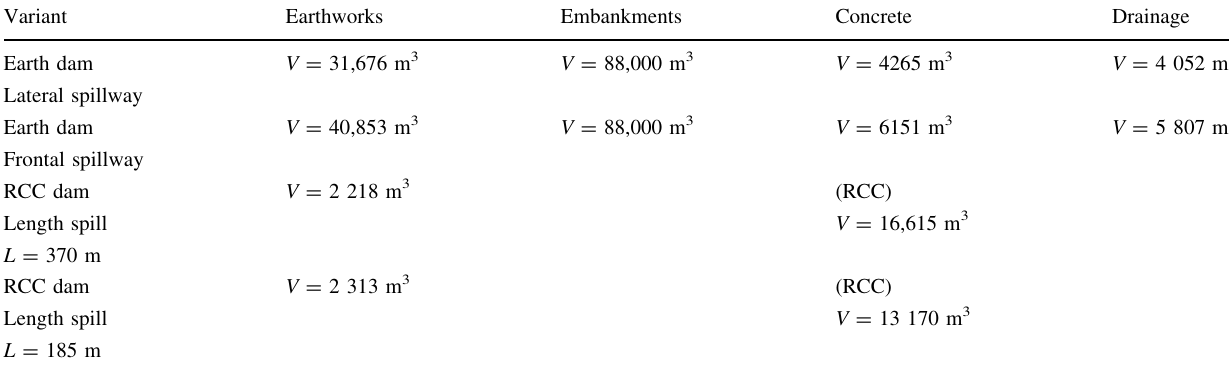
Table 6 Quantity of construction works